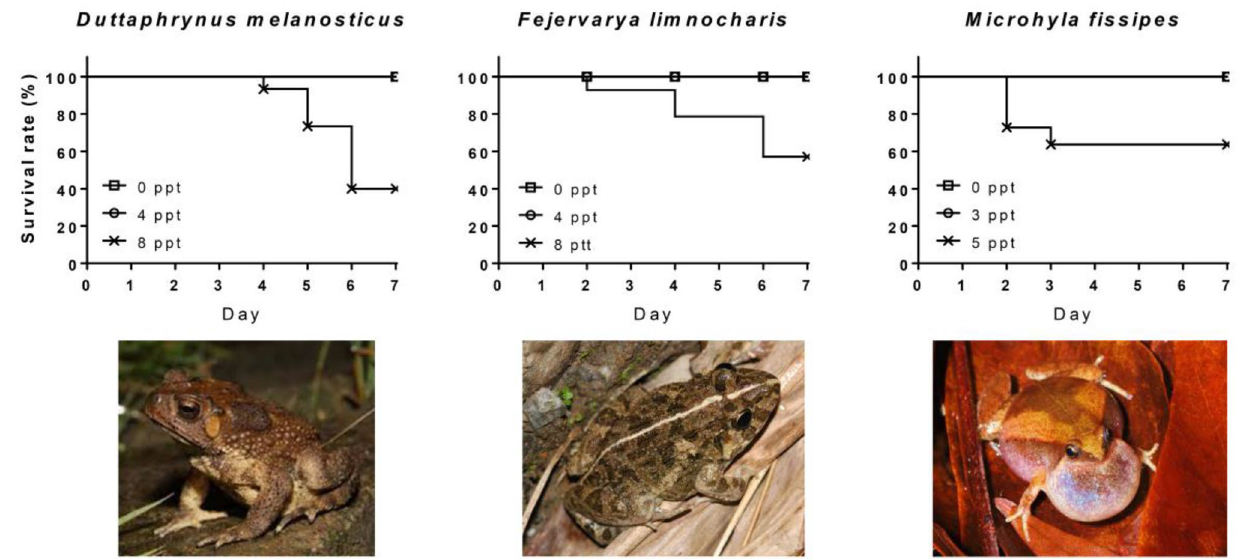
Figure 1. The survival rate of tadpoles under salty water. Survival of Duttaphrynus melanostictus (left), Fejervarya limnocharis (middle), and Microhyla fissipes (right) tadpoles in freshwater (open square), low salinity (open circle), and high salinity treatments (x-mark). Duttaphrynus melanostictus : n = 15, 14, and 15, respectively; F. limnocharis : n = 12, 12, and 14, respectively M. fissipes : n = 10, 10, and 11, respectively. (Photos were taken by M-F Chuang from Taichung City for D. melanostictus , and from Nantou County for F. limnocharis and M. fissipes .)